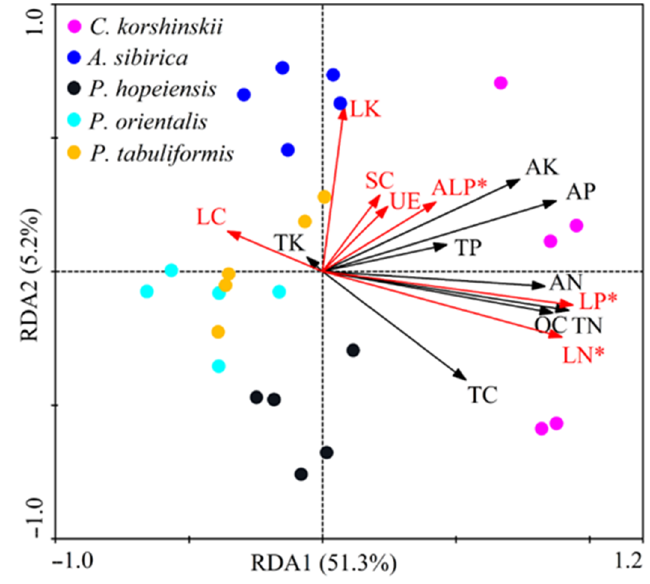
Figure 4. RDA estimating the contribution of chemical litter properties and soil enzyme activities to soil nutrients. The total contribution rate of the four axes in the RDA is 62.2%; the red arrows indicate the effect variables and the black arrows indicate the response variables. * indicates significance at the p < 0.05 level.